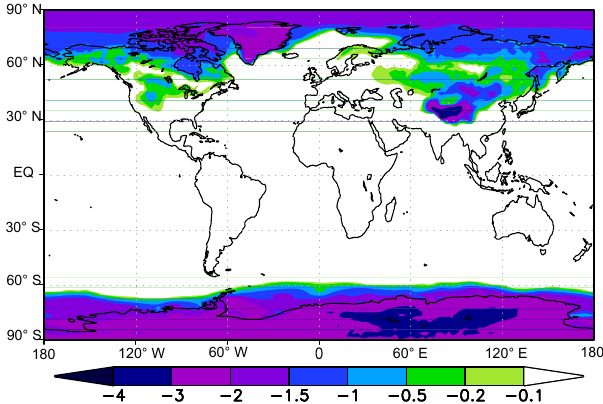
Figure 2. Annual-mean instantaneous radiative effect at the top of the model atmosphere (Wm − 2 ) due to changing the snow grain shape assumption from spheres to the OHC, evaluated through di- agnostic radiation calculations in the SPH